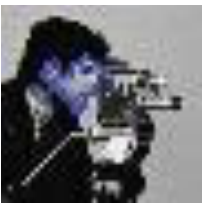
Figure 3. Ant (blue pixels) doesn't always move on edges but shift between sides.